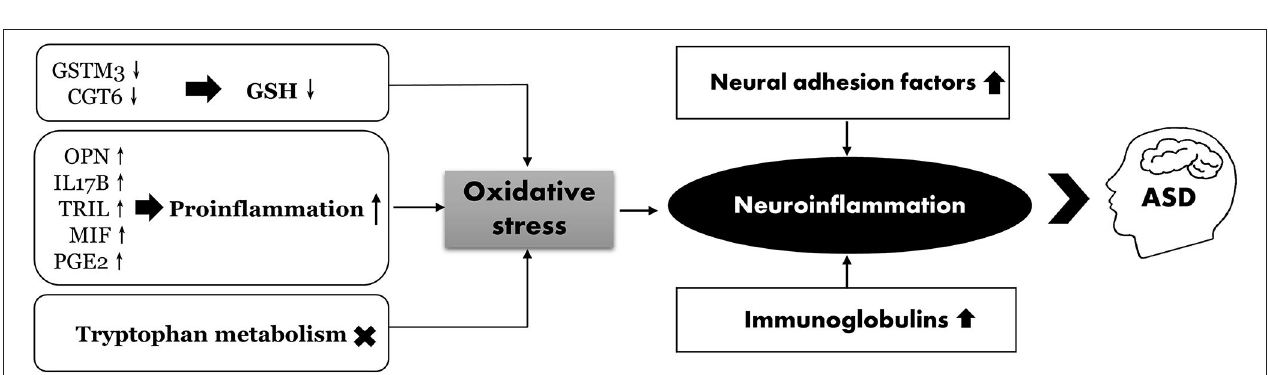
FIGURE 8 | The proposed scheme illustrates neuroinflammation correlated with